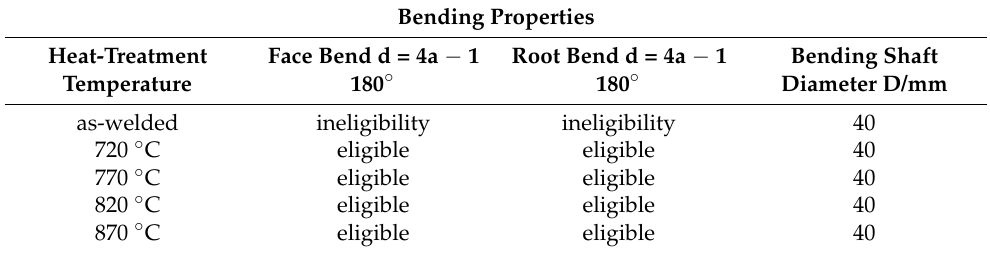
Figure 23. Stretching result diagram.